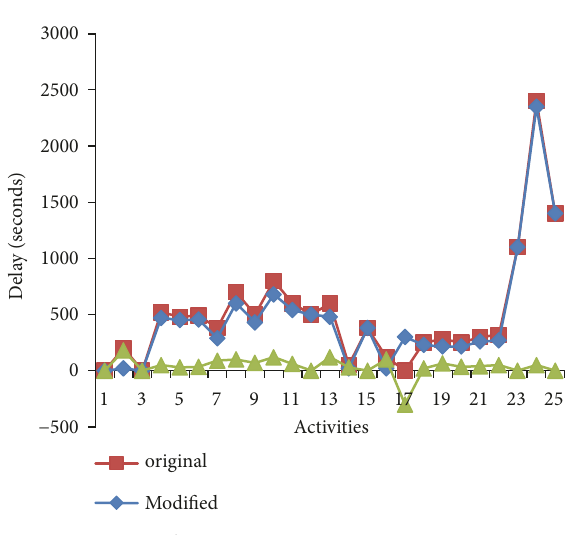
Figure 10: Delay of all activities other than conflict points.